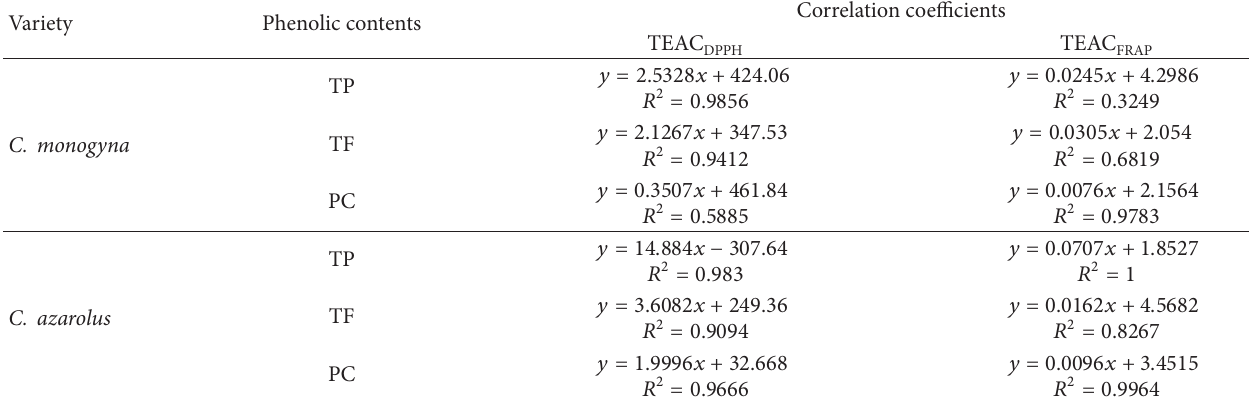
Table 3: Linear correlation of Trolox equivalent antioxidant capacity (TEAC) versus the total phenolic content of crataegus fruit